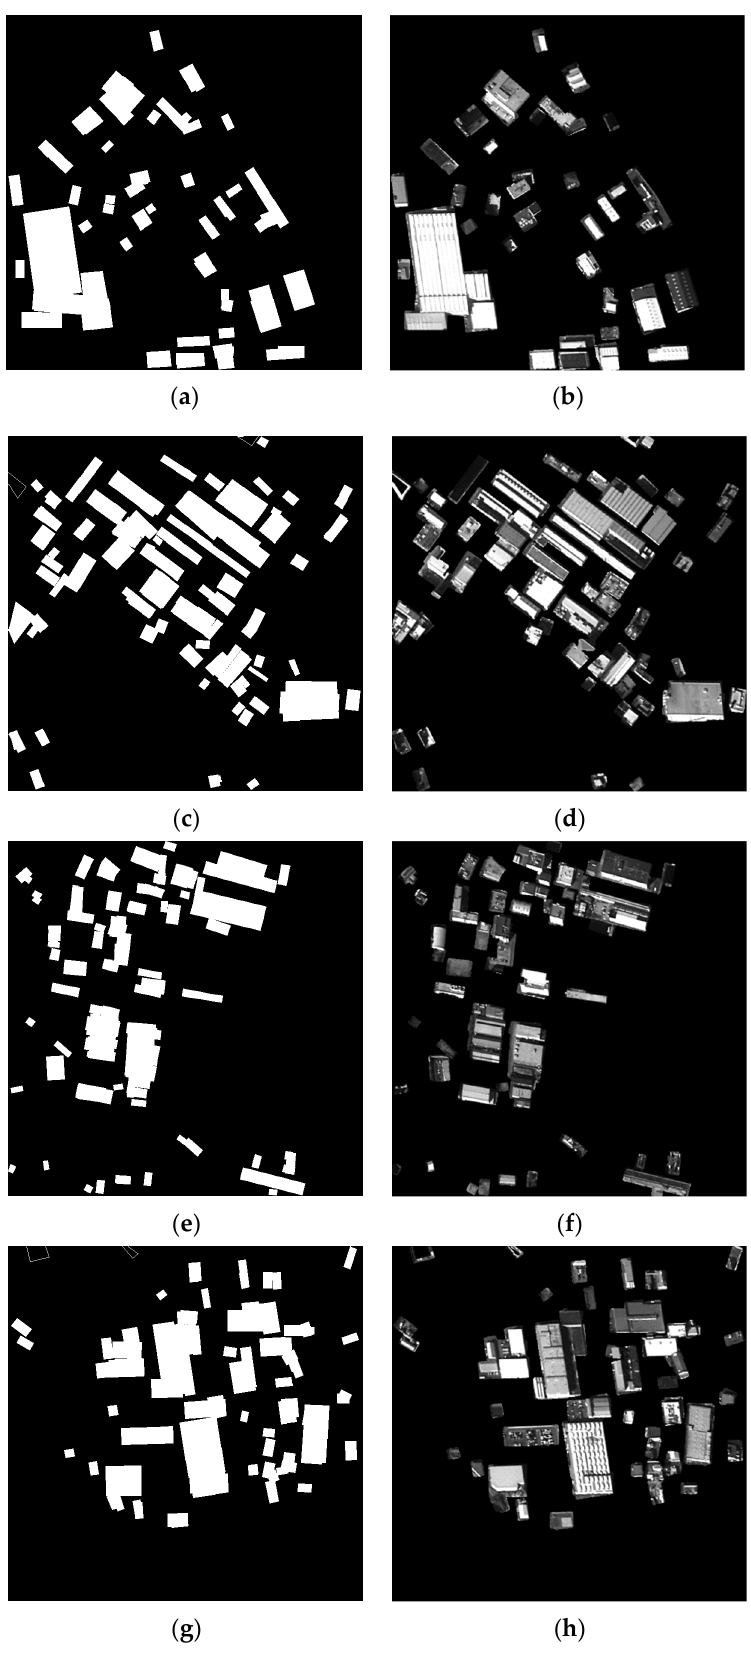
Figure 6. Building detection results based on rectangular approximation. ( a ) Image I mask map, ( b ) Image I detection result, ( c ) Image II mask map, ( d ) Image II detection result, ( e ) Image III mask map, ( f ) Image III detection result, ( g ) Image IV mask map, ( h ) Image IV detection result. Comparing the mask map with the ground truth map reveals that although most of the targets can be detected, there are some false detections in the mask map due to the fact that the selected image is the port area and thus both the trestle and the ship at the port may have a similar shape to the building target, that is, a structure composed of right- angle primitives. There is also a phenomenon of missed detection. For this reason, other features of the target are added to improve the detection accuracy and recall. 3.2. Results of the Diffusion-Based Saliency Model The compactness-based, local contrast-based, and boundary prior-based saliency maps are fused, and the weights of the three saliency maps are assigned to obtain the saliency map fusion result. For overcoming the complex environment around the build- ing, a bounding box proposal is introduced to optimize the saliency map detection results.